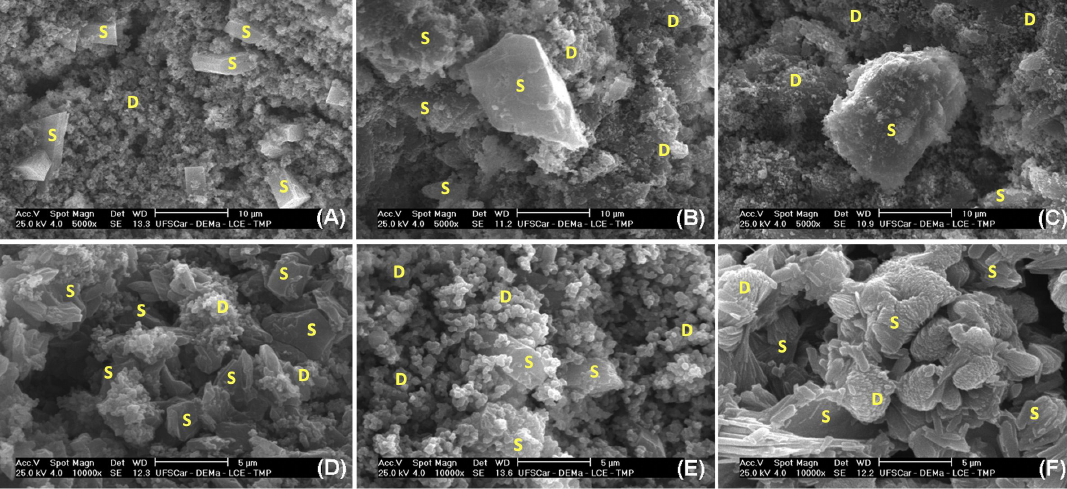
O; (C) C_01 - 80% H 2